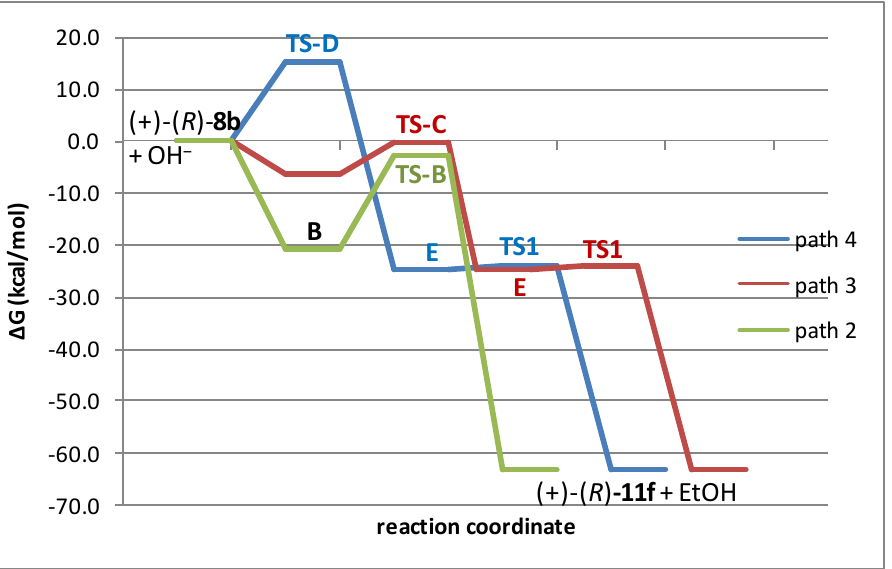
Figure 5. Gibbs free energy profiles for reaction paths resulting in the evolution of EtOH — 2 (green), 3 (red) and 4 (blue); the profiles for the evolution of MeOH are very similar and are omitted for clarity. Table 3. Relative enthalpies and Gibbs free energies (kcal/mol) of sulfuranes (Scheme 2; ∆ H r , ∆ G r —relative to the sum of the free energies of the substrates ((EtO)iPrSOMe ∆ G rel —relative to the most stable sulfurane isomer ( E2 )) in